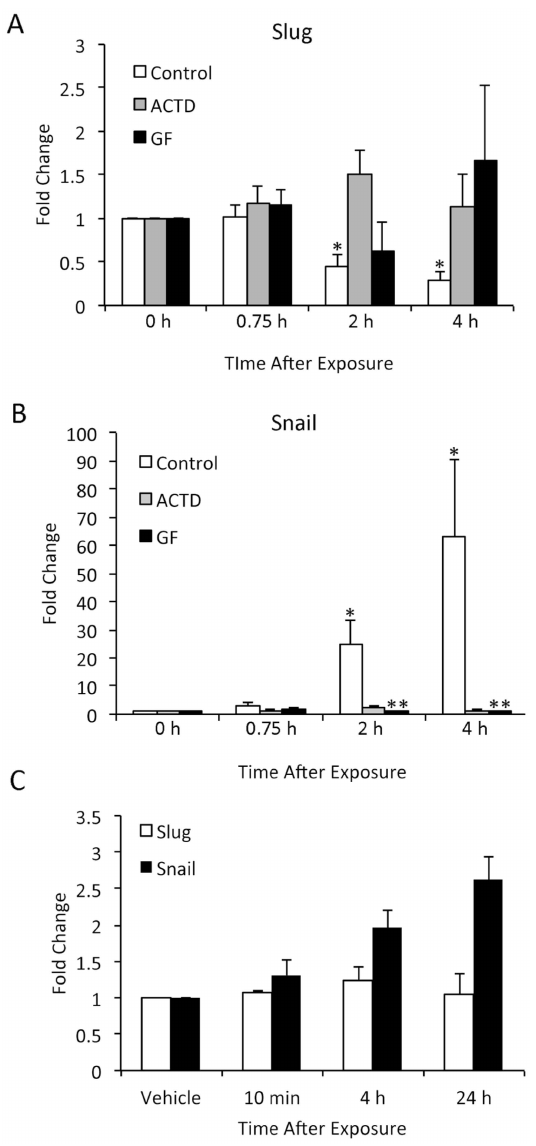
Figure 6. TPA alters the expression of Slug and Snail mRNA in cultured SCC12F cells, and inhibition of PKC activity or downstream signaling pathways abrogates this effect. ( A , B ) SCC 12F cells were treated with TPA in the presence of DMSO vehicle ( C ), actinomycin D (ACTD) or GF 109203X (GF). mRNA was isolated, and Slug (shown in 5A) and Snail (shown in 5B) expression levels were determined by q-RT-PCR. Results are shown as a fold increase compared to 0 h samples. Results were compared by the Kruskal–Wallis test followed by Dunn’s multiple comparison test. * Significantly different from the 0 h samples; ** significantly different from the control sample at that time point. Bars indicate SD. ( C ) Protein from vehicle or TPA-treated SCC 12F cells was analyzed by Western blotting for Slug and Snail, followed by densitometry. Values shown are the average of two independent replicates. Bars indicate the